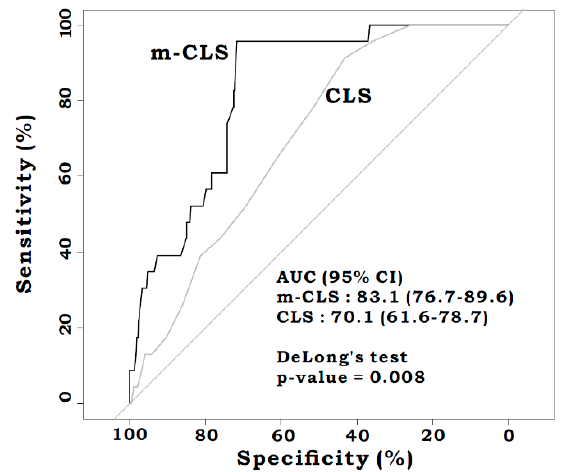
Figure 3. Receiver operating characteristic curves for the m-CLS and CLS in the overall (the train and the validation) set. This comparison revealed that the m-CLS performed better than CLS (AUROC 0.831 versus 0.701, p = 0.008).